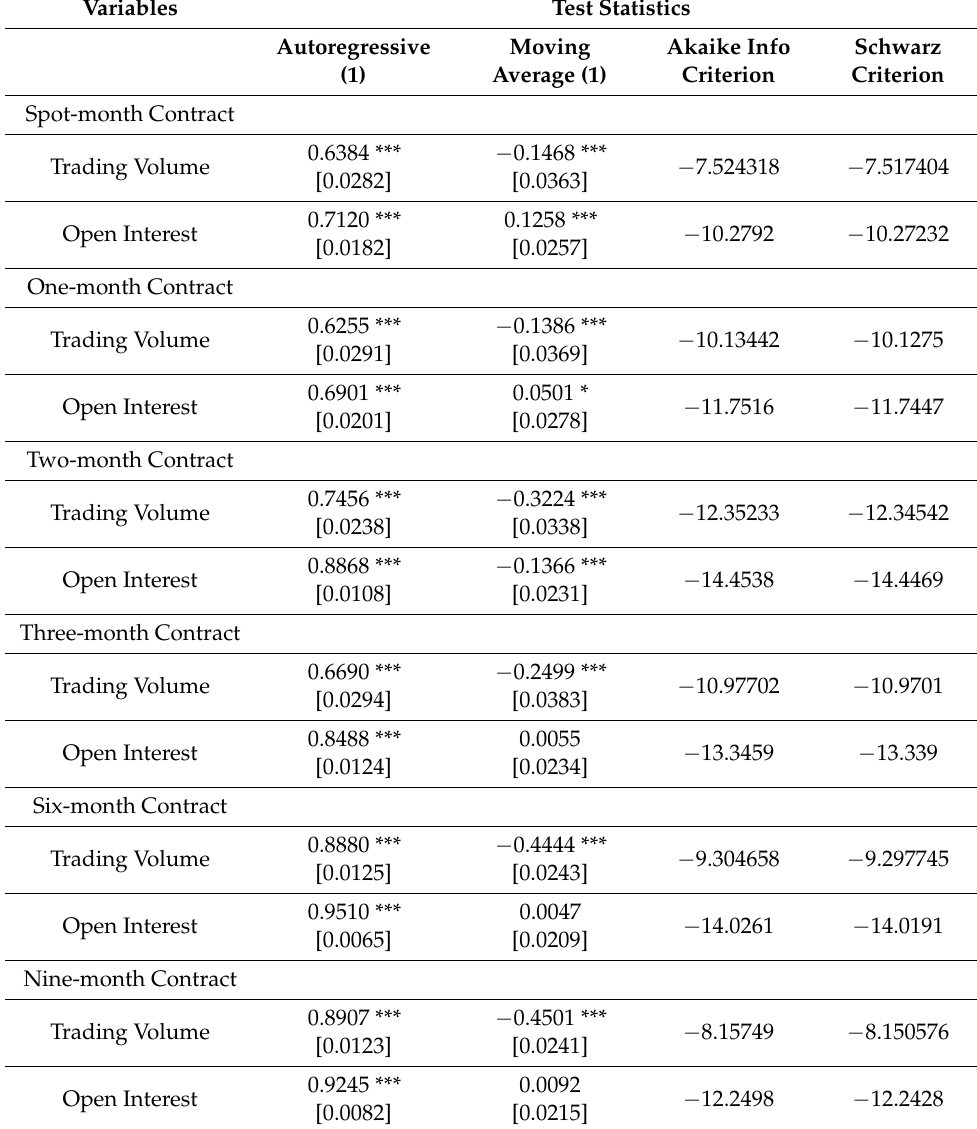
Table 3. Autoregressive and Moving Average Test (ARMA